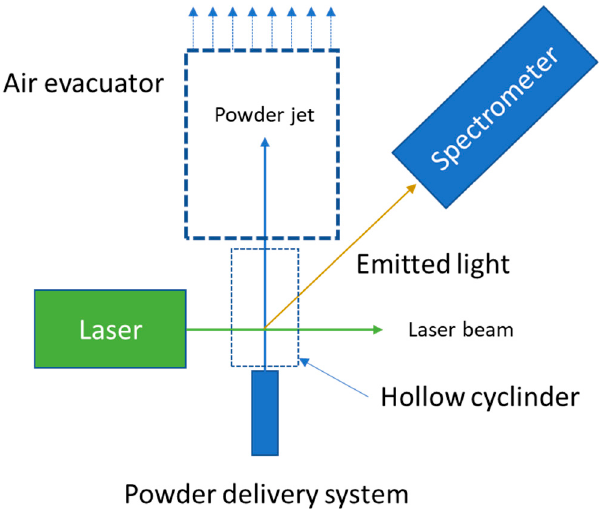
Figure 1. Powder flowmeter; first, the powder passes through a laser beam. The light emitted by the powder is then measured with a spectrometer.